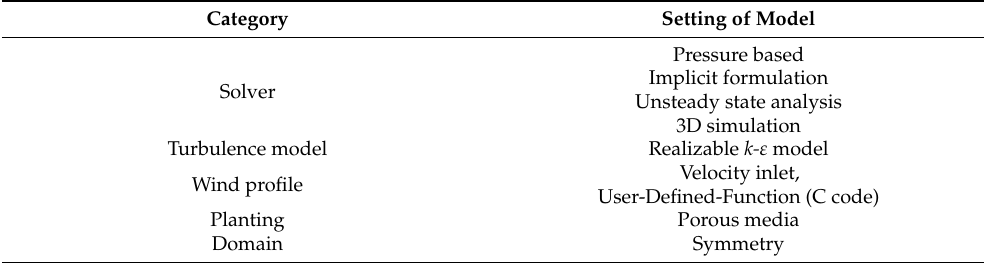
Figure 6. Mesh design of the computational fluid dynamics (CFD) simulation model used in this study (H indicates the height of a building). Table 2. Conditions considered in the computational fluid dynamics (CFD) simulation model design applied in this